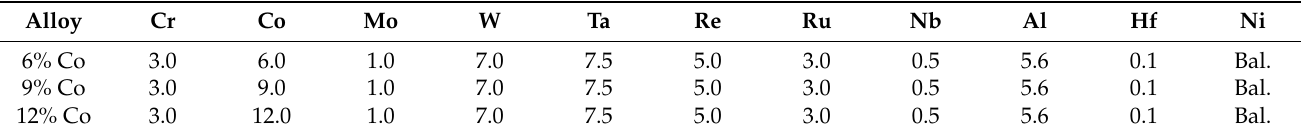
Table 1. Nominal chemical components of the three alloys (mass fraction,